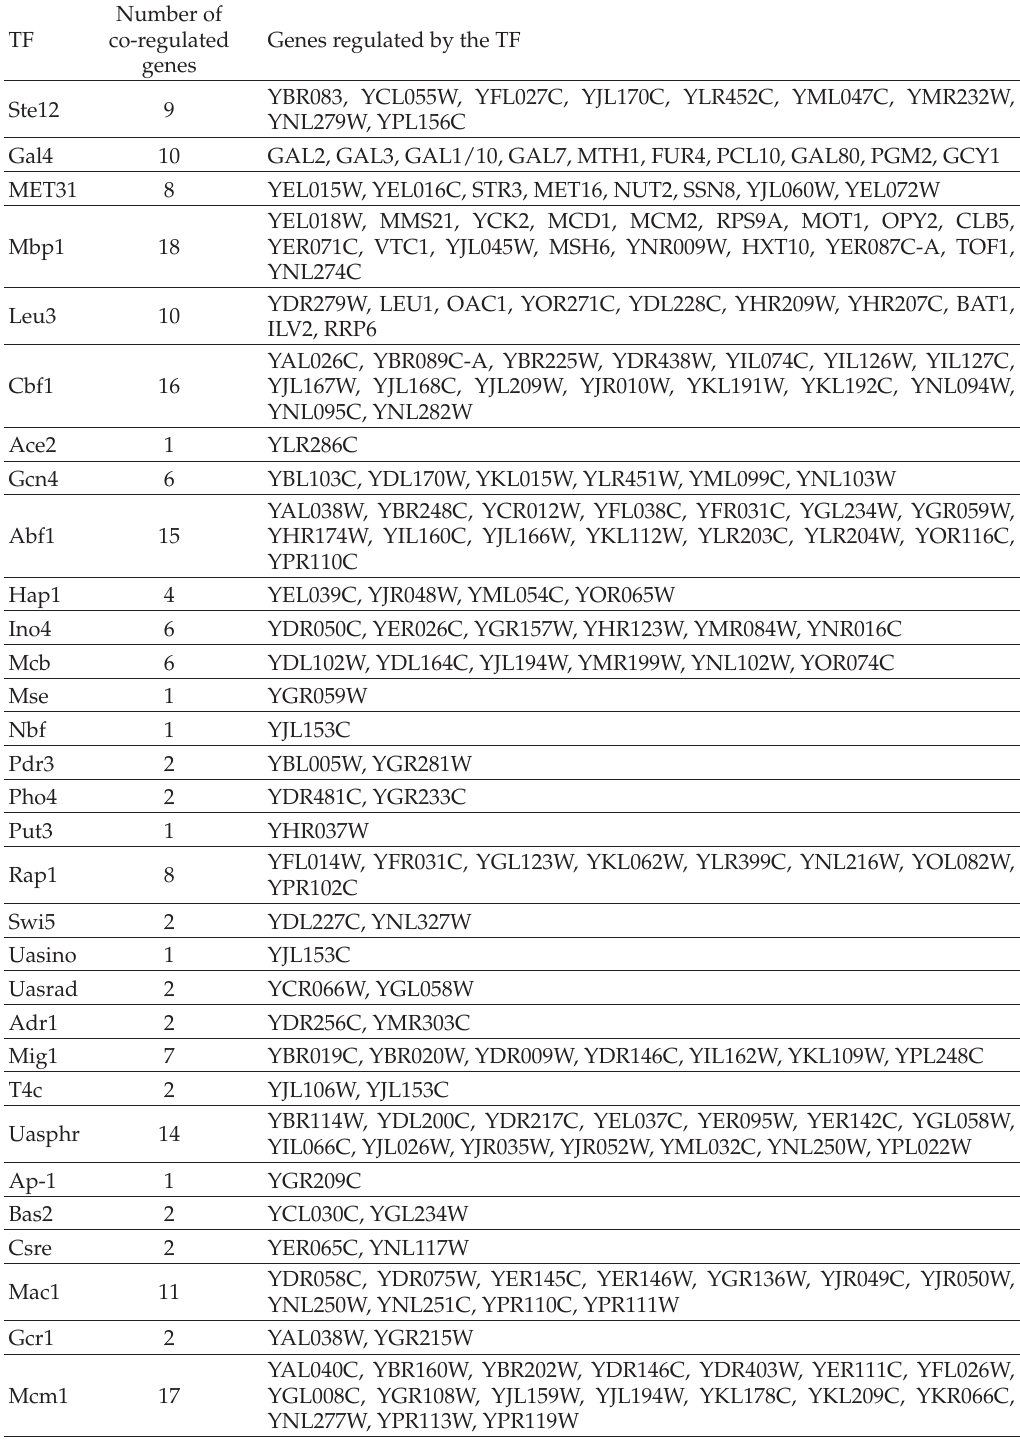
Table 1: Transcription factors and the genes being